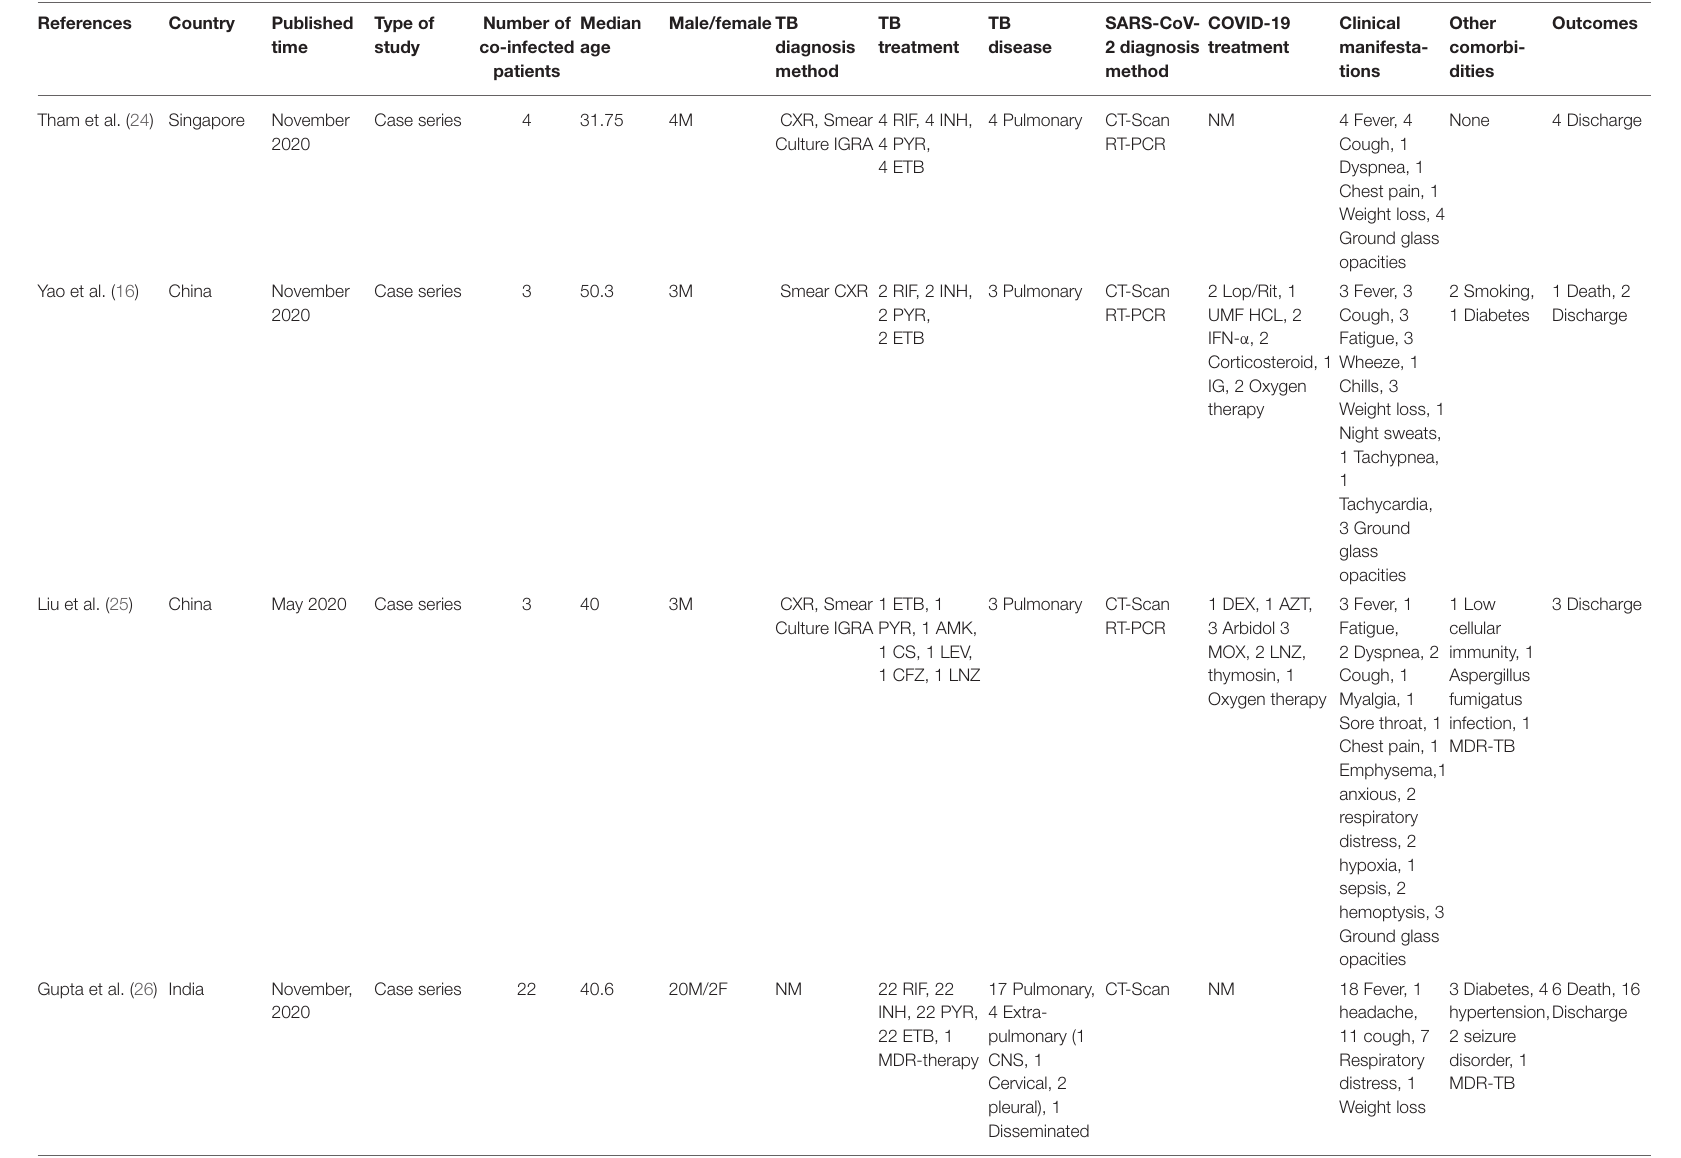
TABLE 1 | Characteristics of the included